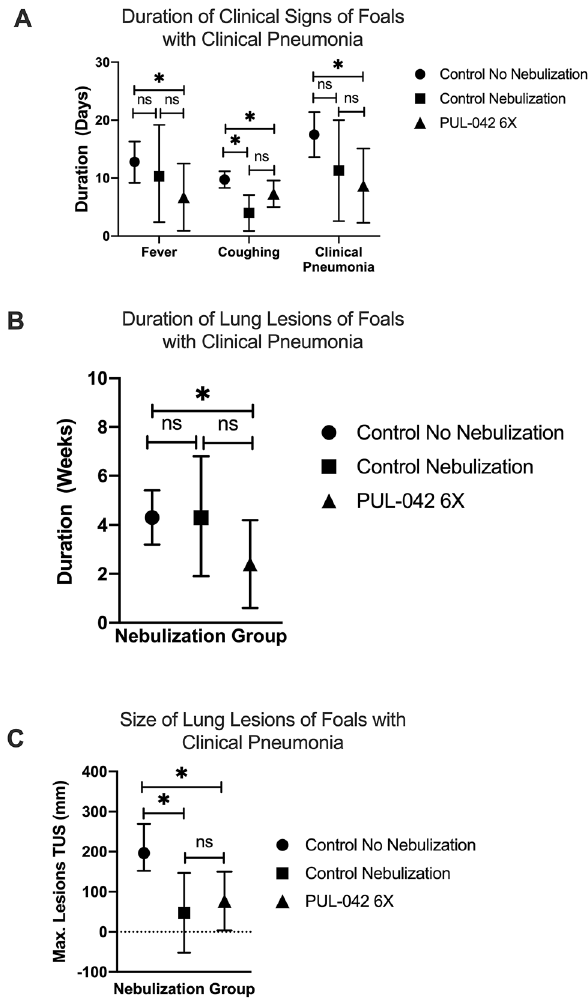
Figure 6. Clinical parameters of foals not nebulized (group control no nebulization; n = 12), nebulized with either PUL-042 6× (139.8 µg Pam2:204 µg ODN diluted in 2.8% glycerol; group PUL-042 6×; n = 7) or glycerol 2.8% (group control nebulization; n = 3) before and after infection with 10 6 virulent R. equi intrabronchially at 28 days of age. ( A ) Non-nebulized foals showed longer duration of clinical signs of pneumonia, coughing, and fever when compared to foals receiving PUL-042 6×. ( B ) Nebulization with PUL-042 6× had shorter duration of presence of abscesses in their lungs upon thoracic ultrasound examination when compared to both control groups, although only group control no nebulization was significantly longer. ( C ) Foals that did not receive any nebulization showed larger sum of ultrasonographic lesions than foals that were nebulized with either PUL-042 6× or glycerol 2.8%. Mean is represented by the symbol (circle for control no-nebulization; square for control nebulization; and triangle for PUL-042 6×) and 95% confidence interval